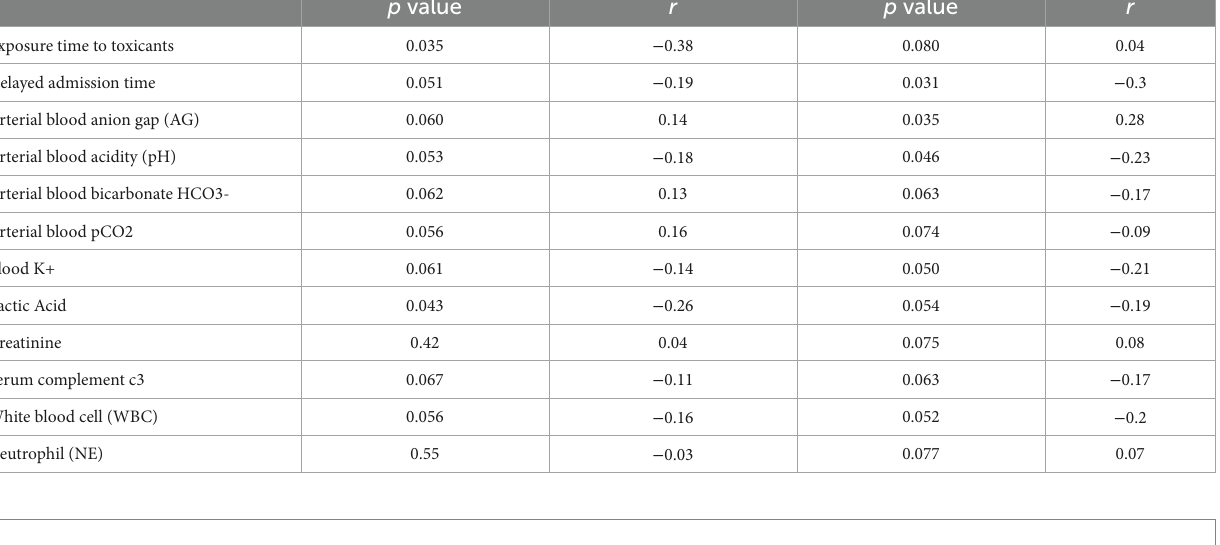
TABLE 4 Spearman correlation analysis of VA prognosis and influencing factors. Variable